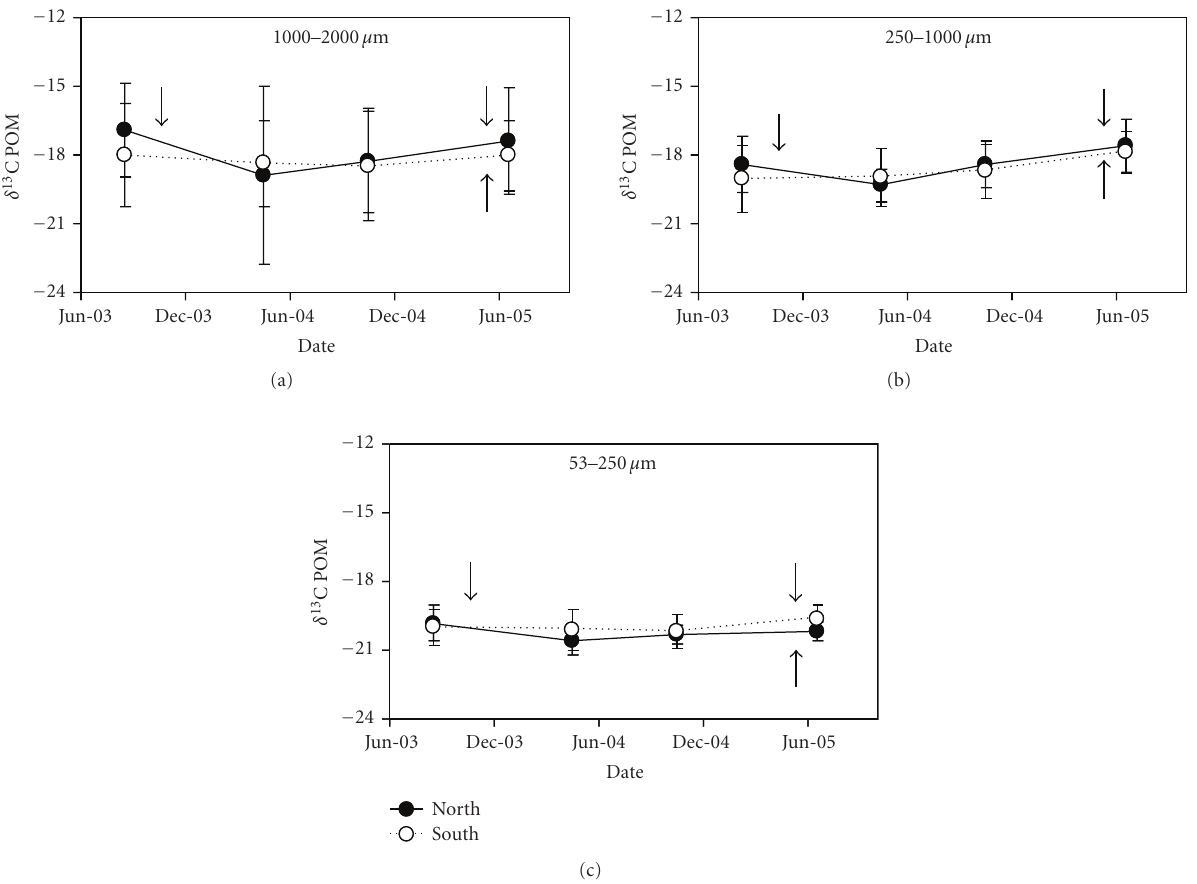
Figure 6: Short-term e ff ect of tillage on δ 13 C particulate organic matter (POM). Arrows indicate the time of tillage operations. The north field was converted from no-till to standard tillage in August 2003, while the south field remained under no-till. Both fields were then converted to minimum tillage in May 2005. Bars indicate the standard deviation of the